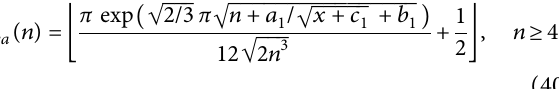
� G ( c ) when − 4 ≤ c 2 2 1